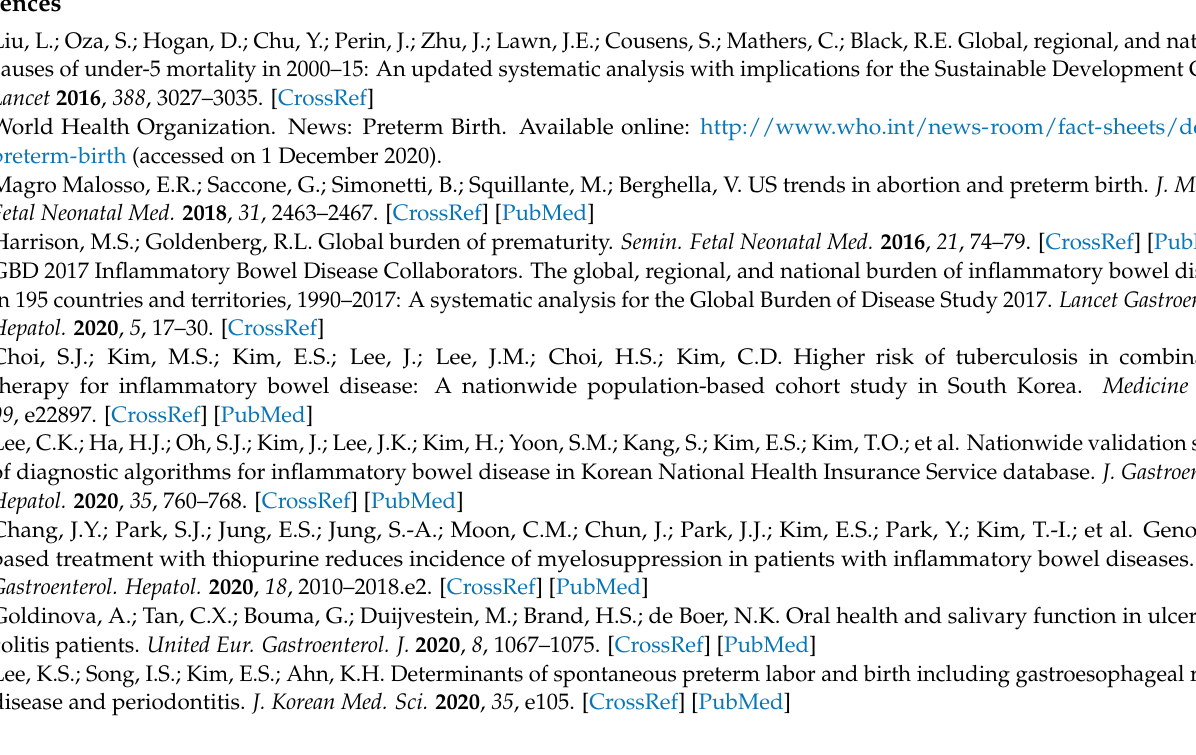
on Preterm Birth and Its Determinants of All; Table S4: Descriptive Statistics on Preterm Birth and Its Determinants of Ulcerative-Colitis Group; Table S5: Descriptive Statistics on Preterm Birth and Its Determinants of Crohn Group; Table S6: Descriptive Statistics on Preterm Birth and Its Determinants of Non-Inflammatory-Bowel-Disease Group; Figure S1: Average Values of Random Forest Variable Importance for PTB 1, PTB 2, PTB 3 and PTB 4: Ulcerative-Colitis Group; Figure S2: Average Values of Random Forest Variable Importance for PTB 1, PTB 2, PTB 3 and PTB 4: Crohn Group; Figure S3: Average Values of Random Forest Variable Importance for PTB 1, PTB 2, PTB 3 and PTB 4: Non-Inflammatory-Bowel-Disease